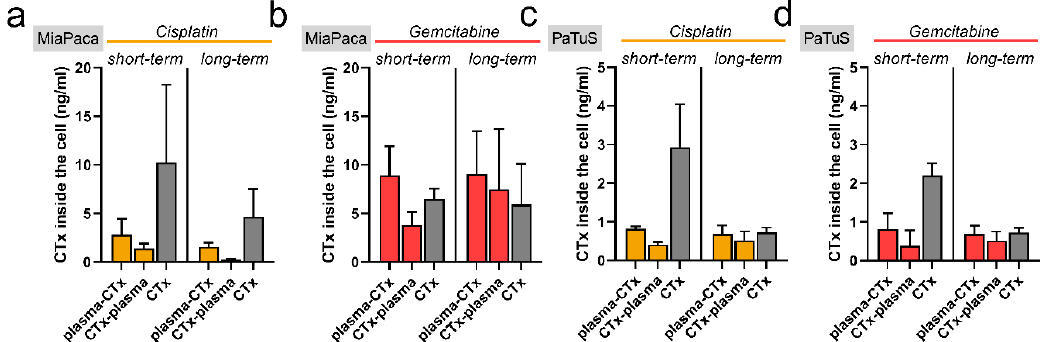
Figure 6. Initial cisplatin and gemcitabine uptake to pancreatic cancer cells were most effective in mono treatments but declined over time. ( a , d ) mass spectrometry quantification of the amount of the cisplatin and gemcitabine taken up to MiaPaca ( a , b ) and PaTuS ( c , d ) pancreatic cancer cells at short (0.5 h) and long-term (24 h). Data are mean + SEM from three independent experiments.